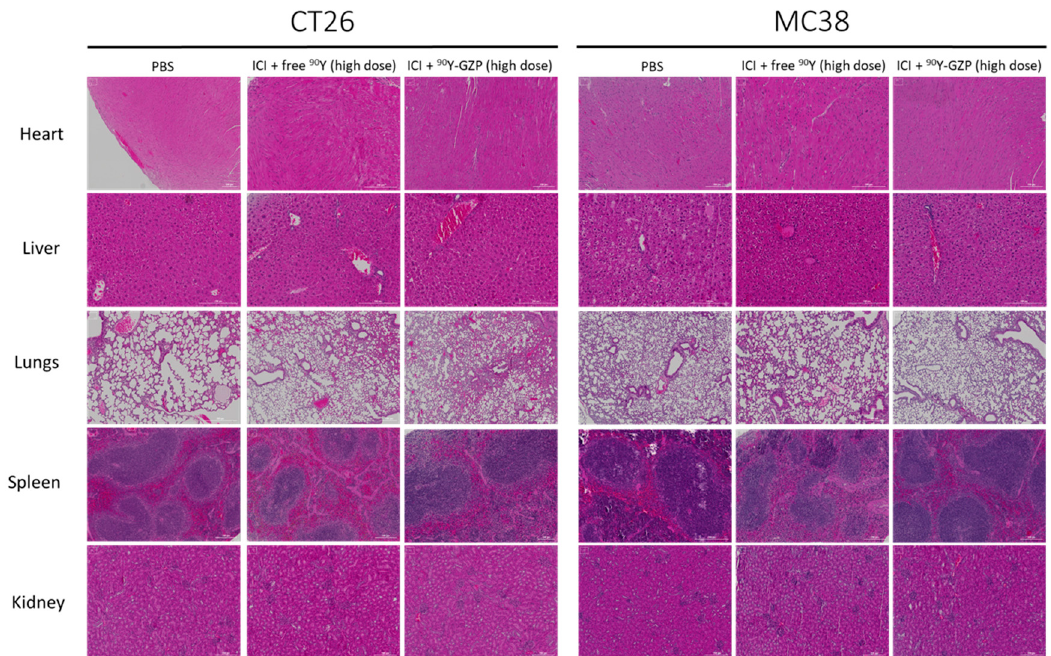
Figure 4. Histological evaluation of major organs reveals no systemic toxicity after both doses of 90 Y-GZP at either high or low dose. Scale bar = 200 µm.